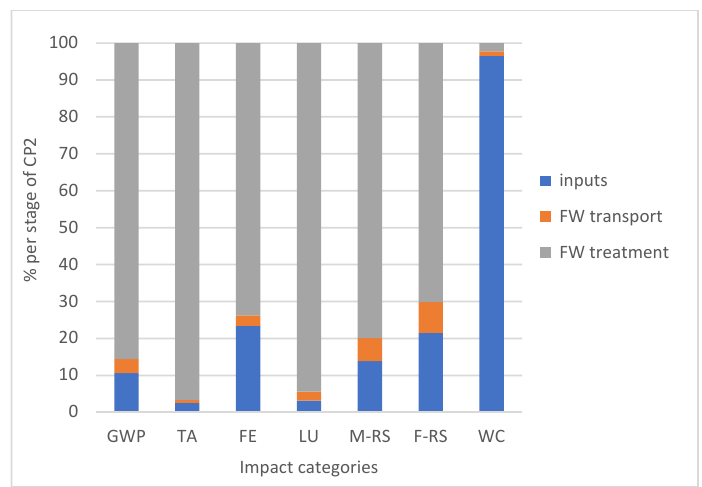
Figure 8. Impacts from FW Composting in a centralized scenario (CP1).